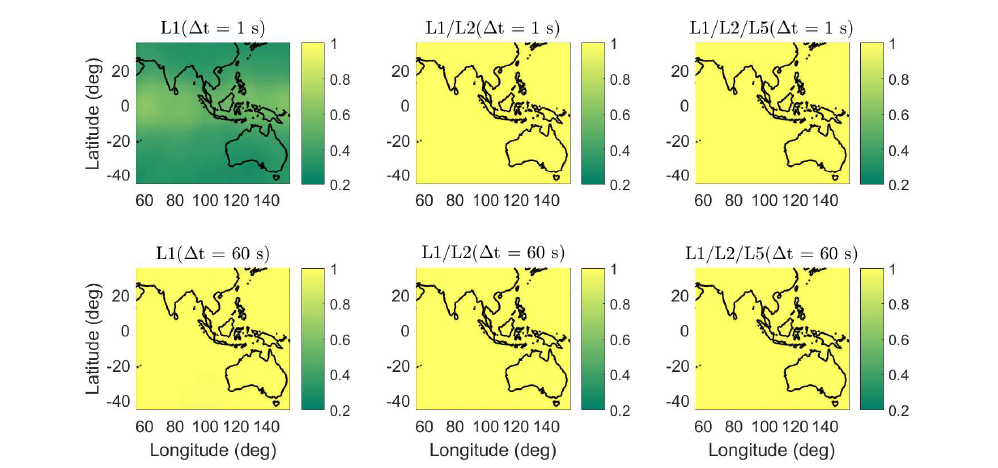
Figure 9. Average formal IB ASRs on single-, dual-, and triple-frequencies in the phase-only two-epoch case. The time span between the two epochs are 1 ( top ) and 60 s ( bottom ).